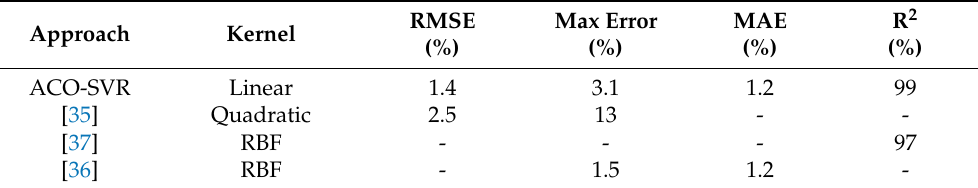
Table 6. Comparison of error between estimated and expected SoC (proposed model implemented on FPGA vs. other